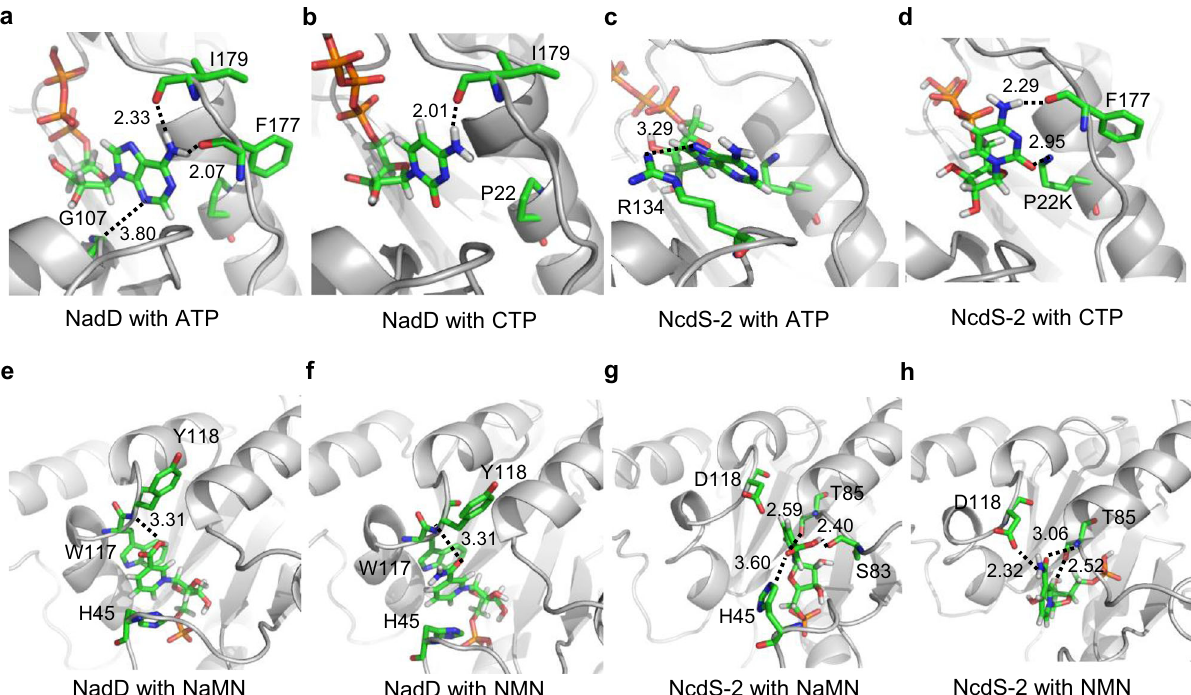
Fig. 3 Docking analysis for substrate in wild-type NadD and NcdS-2. The docking poses for ATP ( a ) and CTP ( b ) with NadD. The docking poses for ATP ( c ) and CTP ( d ) with NcdS-2. The docking poses for NaMN ( e ) and NMN ( f ) with NadD. The docking poses for NaMN ( g ) and NMN ( h ) with NcdS-2. The protein was shown as cartoon mode and in light gray. The substrate and the key residues were shown as stick mode. Green, carbon atoms. Blue, nitrogen. Gray, hydrogen. Red, oxygen. The dashed line indicates the hydrogen bond between ligand and receptor. The number marked near the dashed line represents the distance between two atoms (unit,